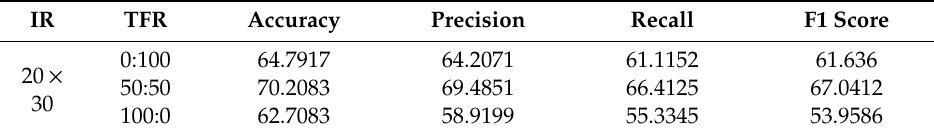
Table 5. Performance of AV-TFN as Tensor Fusion Rate (TFR)